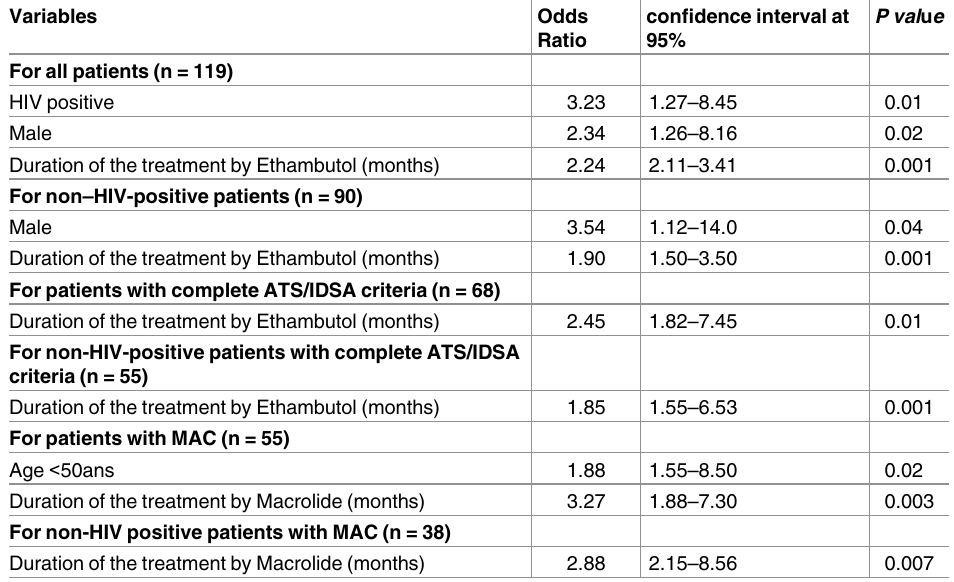
Table 5. Factors associatedwith improved status at one year, multivariate